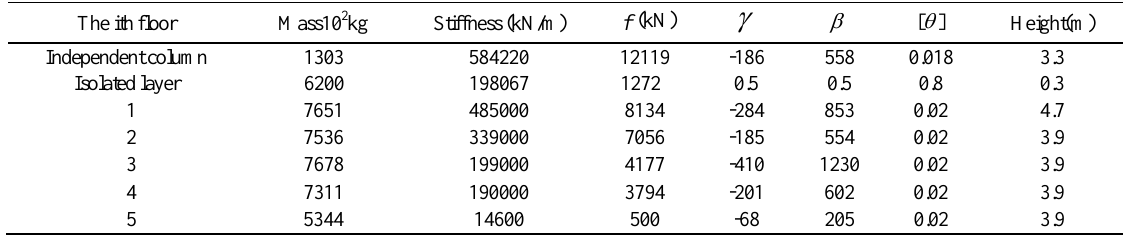
Table.1 Bouc-Wen model parameters of the isolated